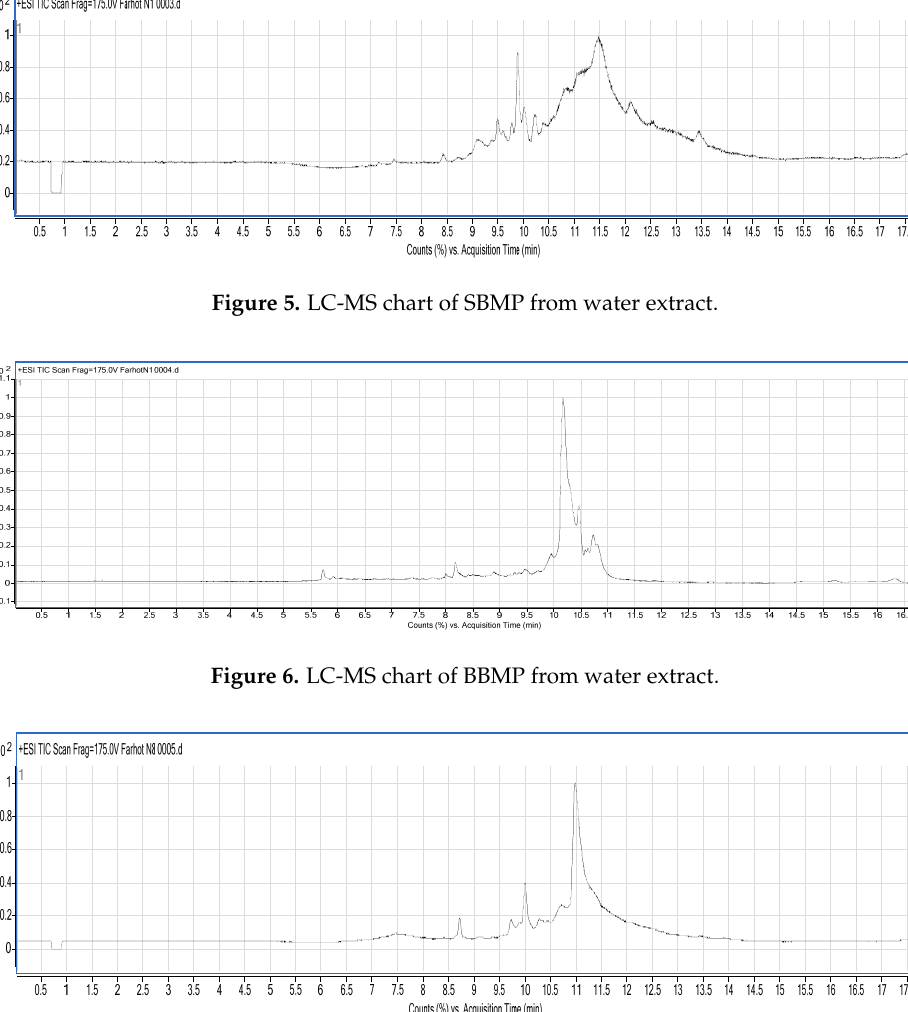
Figure 7. LC ‐ MS chart of CBMP from 50% ammonium sulfate precipitation part. Table 7. LC–MS data analysis of four extraction parts.